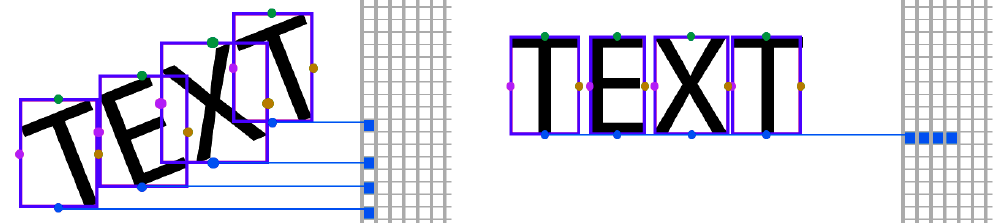
Figure 5. Projection profiling of AABBs’ edge midpoints, on the histogram.